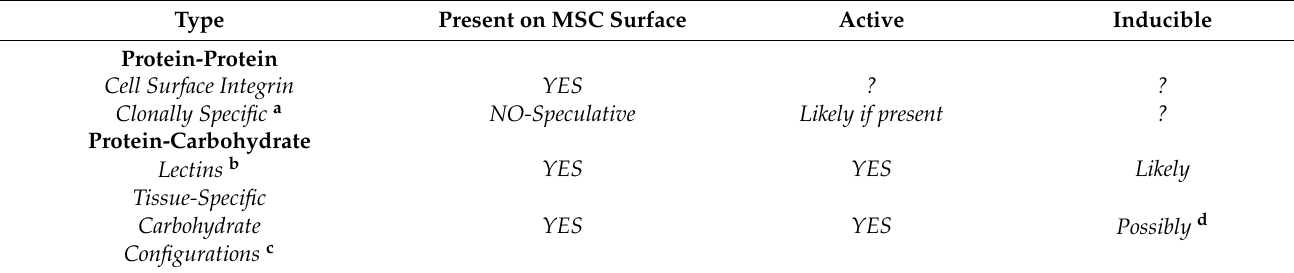
Table 1. Summary of potential endogenous molecular recognition system options for